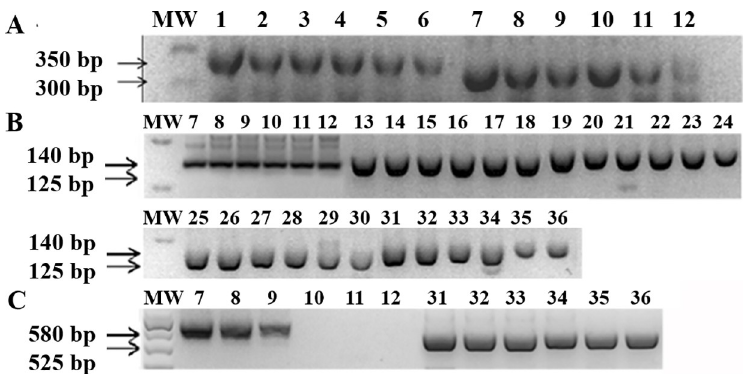
Fig 5. Analytical sensitivity of multilocus conventional PCR for T . cruzi genotyping from spiked blood samples. The PCR product sizes are indicated on the left by arrows. In A, SL-IR I and II target. In B, 24S α (second round) target. In C, A-10 target. MW: DNA ladder (100 or 50 bp). Lanes 1–6: Dm28c clone (TcI); 7–12: Y strain (TcII); 13–18: INPA 3663 strain (TcIII); 19–24: INPA 4167 strain (TcIV); 25–30: Bug 2149 clone (TcV); 31–36: CL strain (TcVI). For all samples, Guanidine-EDTA blood was spiked with T . cruzi ranging from 10 4 to 0.5 par. Eq./mL (10 4 , 10 3 , 10 2 , 10, 1 and 0.5 par. Eq./mL) before DNA